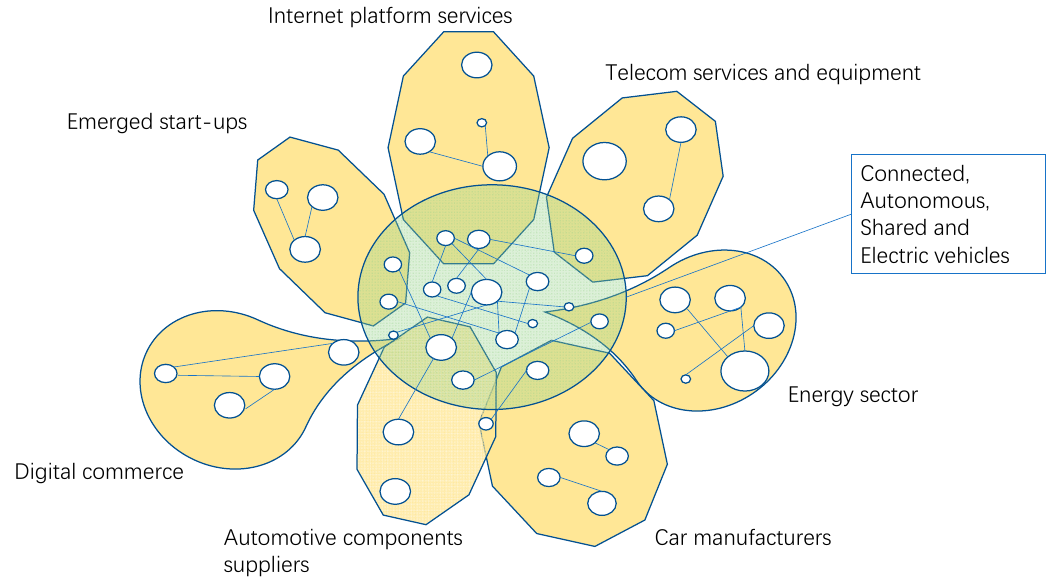
Figure 1. Regime confluence regarding new network emergence.